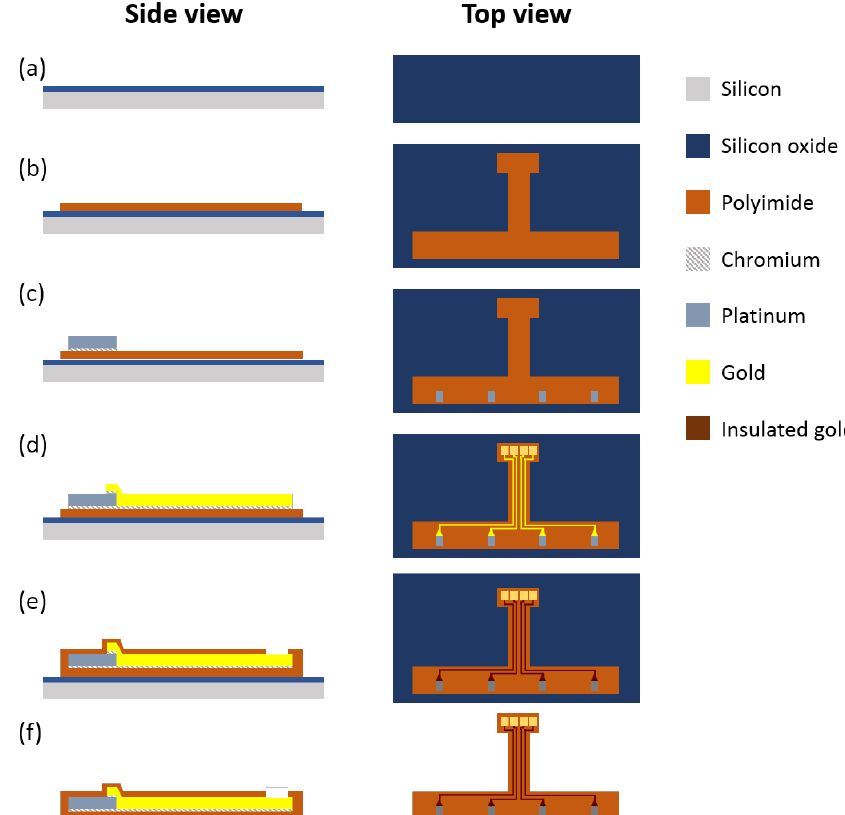
Figure 2. Illustration of the microfabrication process. ( a ) Deposition of a silicon oxide sacrificial layer on a 100 mm bare silicon wafer. ( b ) Deposition of the first polyimide layer. Micropatterning of ( c )